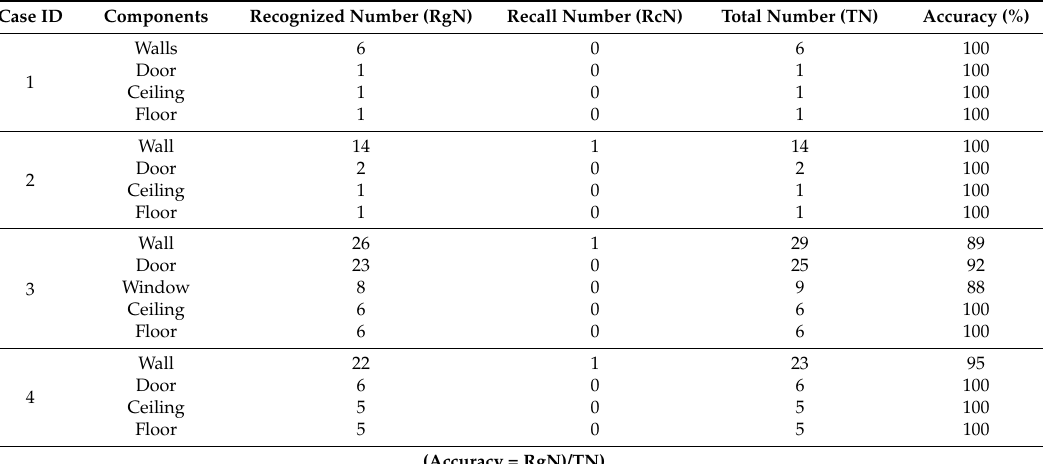
Figure 12. Reconstruction results for case study (1). Table 1. Evaluation of the extracted components.